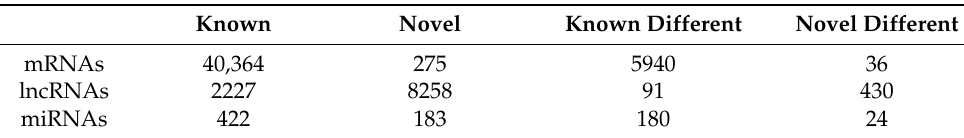
Table 1. Summary of identified genes and